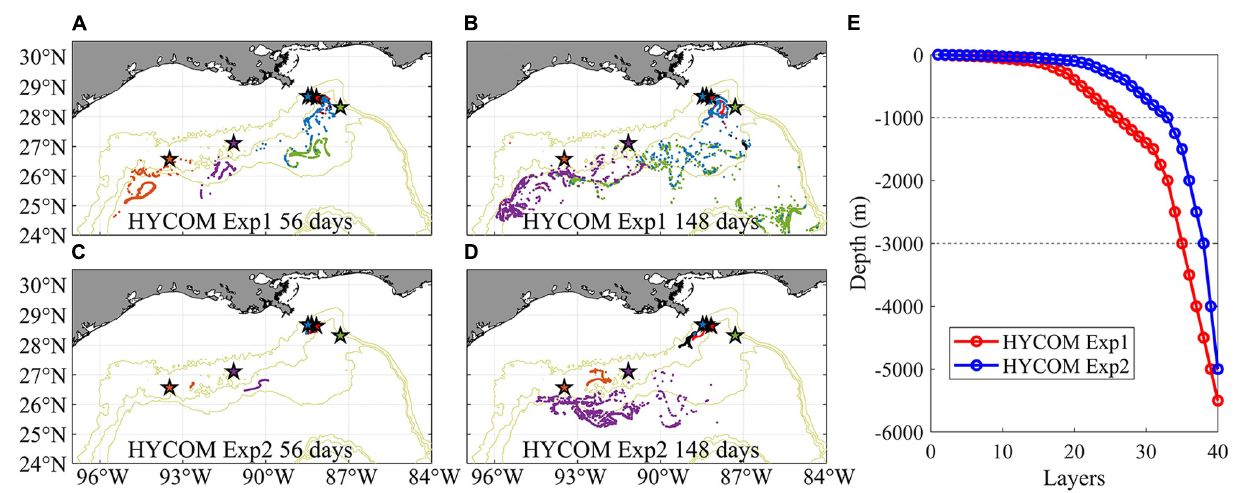
FIGURE 12 | Near-bottom distribution of Lagrangian larval particles released in 2-dimensional HYCOM Exp1 (A,B) and HYCOM Exp2 (C,D) fields in April 2011 after 56 days (A,C) and 148 days (B,D) tracking, respectively. Each dot represents the position of a particle. Particles from different sites are colored consistently with previous figures. The setup of vertical layers in each experiment is shown in panel (E) .